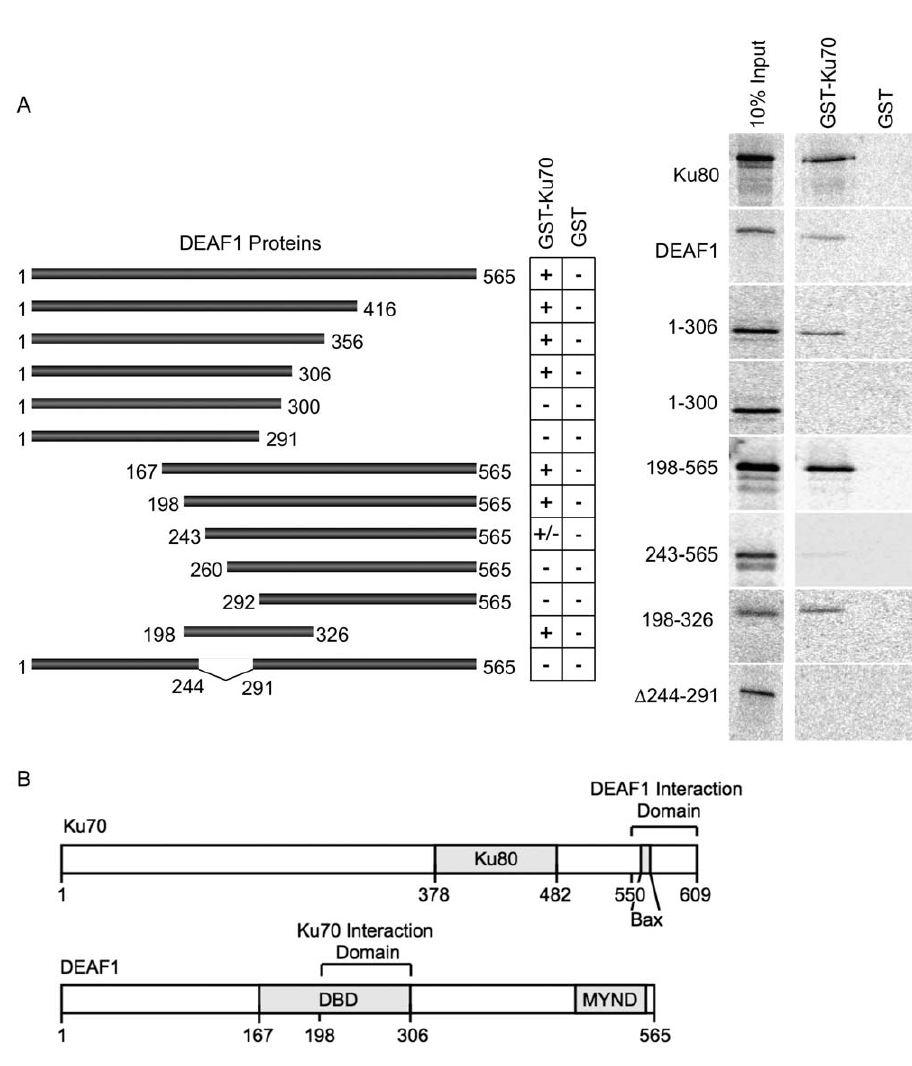
Figure 4. The DEAF1 DNA binding domain interacts with Ku70. ( A ) DEAF1 proteins with C-terminal and/or N-terminal deletions were radiolabeled with [ 35 S]methionine by in vitro translation and used in GST pull-downs. 10% of the [ 35 S]-labeled proteins (10% input) used in the pull- downs are shown to the left of the pull-down results obtained with GST-Ku70 and GST. Schematic representations of all the DEAF1 translated proteins tested are shown in the left panel. Results are summarized as a positive interaction ( + ) or no interaction ( 2 ). Ku80 interaction with GST-Ku70 was used as a positive control. ( B ) A schematic summary of the DEAF1 and Ku70 proteins and the interaction domains deduced from these experiments. Also shown are the Bax interaction domain [20,24], the MYND (zinc binding) domain [25], and DBD (DNA binding